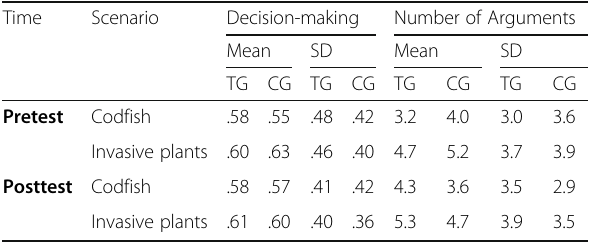
Table 3 Descriptive statistics of Study